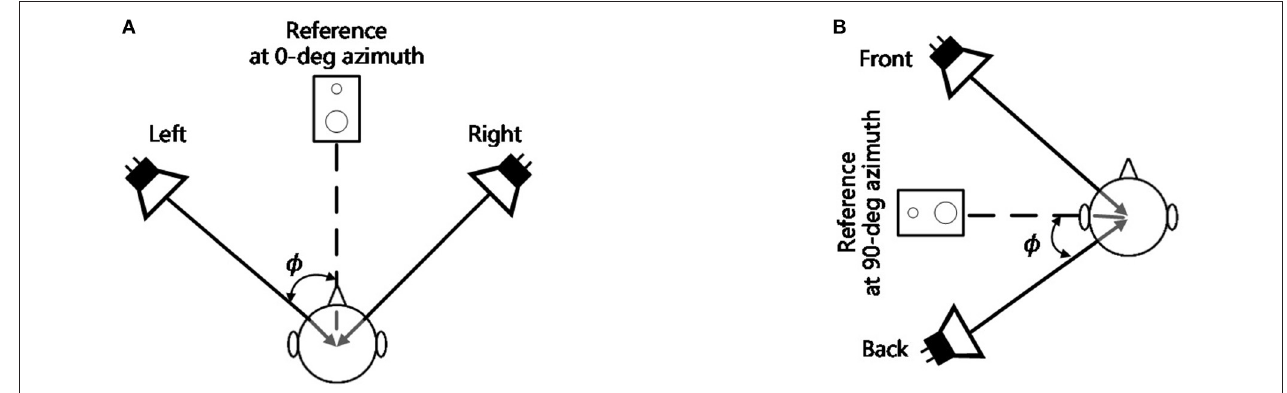
FIGURE 2 | The verification system configuration. (A) The configuration of the frontal MAA measurement experiment (0 ◦ azimuth), the angle φ = ± 1 ◦ , ± 2 ◦ , ± 4 ◦ , ± 8 ◦ ; (B) The configuration of the lateral MAA measurement experiment (90 ◦ azimuth), the angle φ = ± 1 ◦ , ± 2 ◦ , ± 4 ◦ , ± 8 ◦ , ± 15 ◦